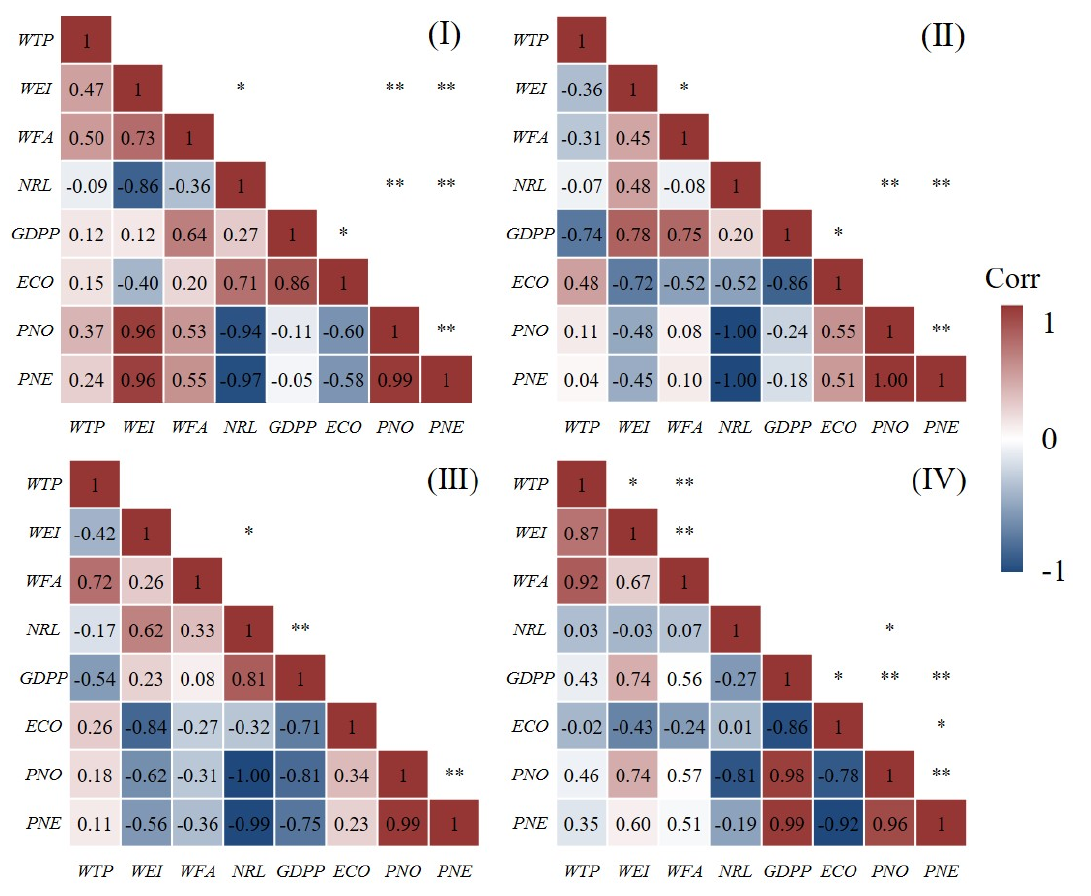
Figure 7. Correlation heat map of socioeconomic conditions in different farming types. “*” indicates significant correlation at the 0.05 level. “**” indicates significant correlation at the 0.01 level. ( I ) Hebei, Shandong, and Henan low-lying plains. ( II ) pre-mountain plain area in Yanshan and Taihang Mountains. ( III ) Huang-Huai plain area. ( IV ) Shandong hilly area.